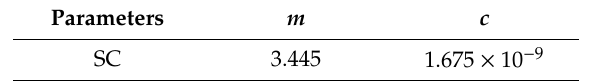
Table 6. Material parameters in the Paris equations of the length-equivalent single crack.